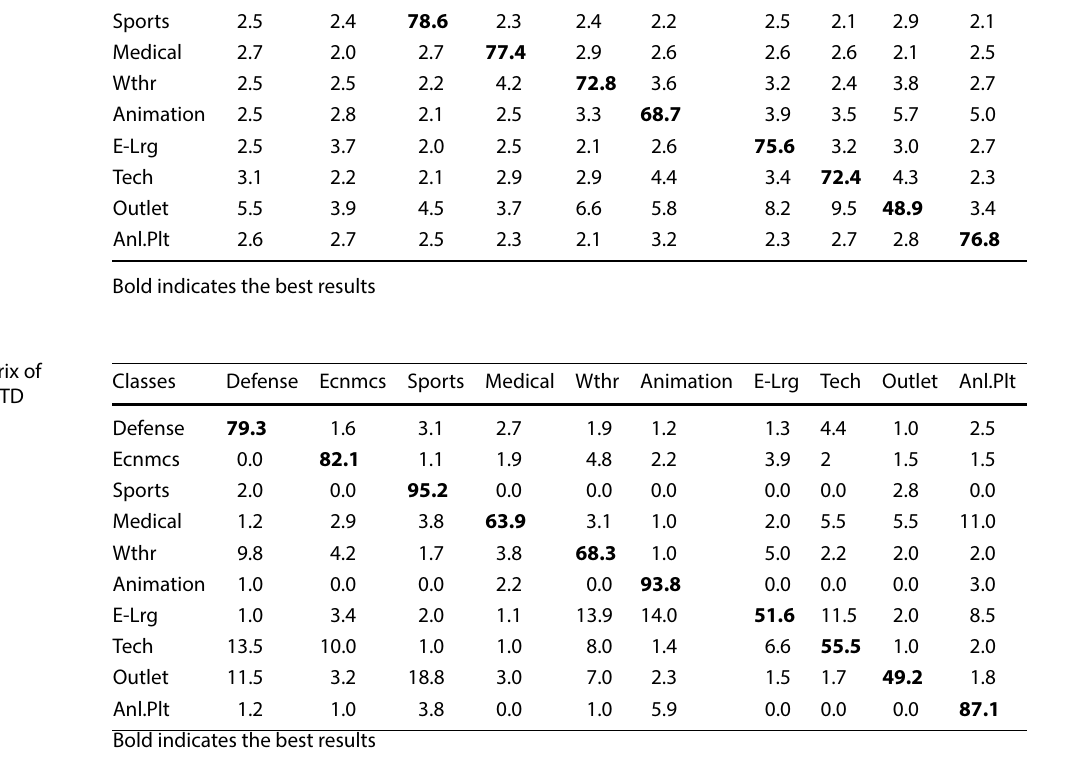
Table 5 Confusion matrix of the GOOGLE API method [35] on STD dataset (ACR: 71.7%)